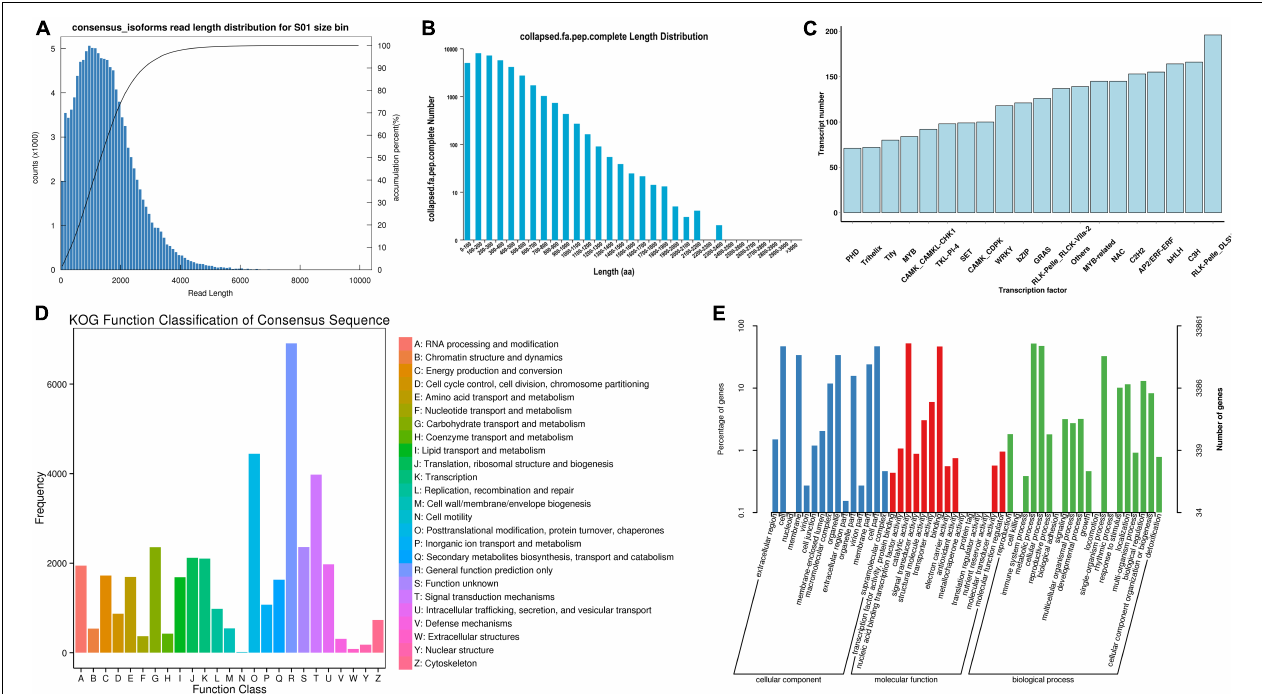
FIGURE 1 | Sequencing results of third-generation transcriptome. (A) Length distribution of transcripts after redundancy removal; (B) Length distribution of complete ORF; (C) Statistics of different types of transcription factors; (D) KOG function annotation; and (E) GO function